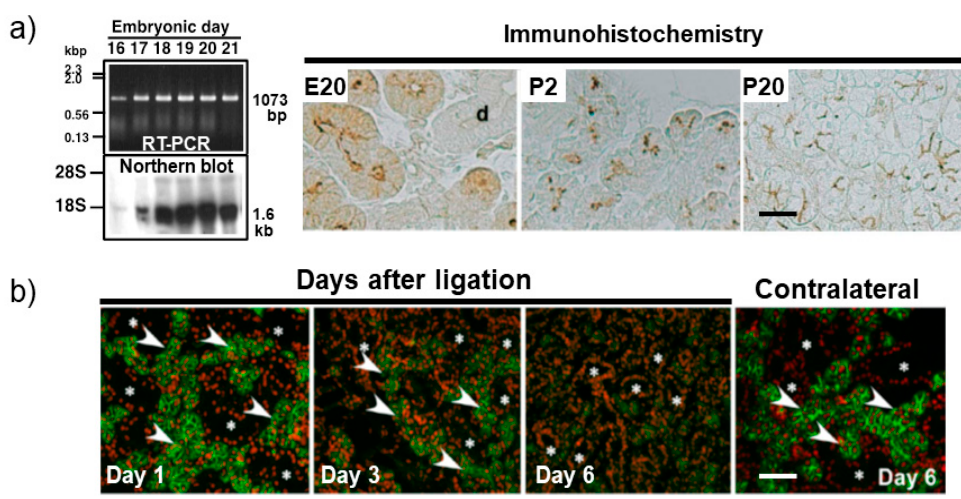
Figure 1. Expression and localization of aquaporin 5 (AQP5) in the developing submandibular gland (SMG) of rats ( a ), and in the ligated SMG of mice ( b ). ( a ) Expression of AQP5 mRNA in the embryonic rat SMG was analyzed by reverse transcriptase-polymerase chain reaction (RT-PCR) and Northern blot analyses. Localization of AQP5 protein was analyzed by immunohistochemistry in the rat SMG at the indicated prenatal and postnatal days. In the right panel, “d” indicates typical duct, and a scale bar, 25 µ m; ( b ) Effects of duct ligation of the mouse SMG on changes in the immunohistochemical localization of AQP5 was analyzed. Green fluorescence indicates the localization of AQP5 on the indicated day after ligation. Arrowheads and asterisks indicate typical acini and ducts, respectively. A scale bar, 100 μ m. ( a , b ) modified from [15,27], respectively .